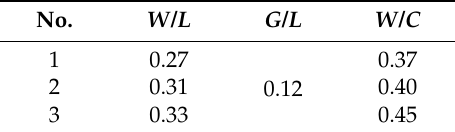
Table 6. Comparison between SRM mixing ratios and cement paste mixing ratios.